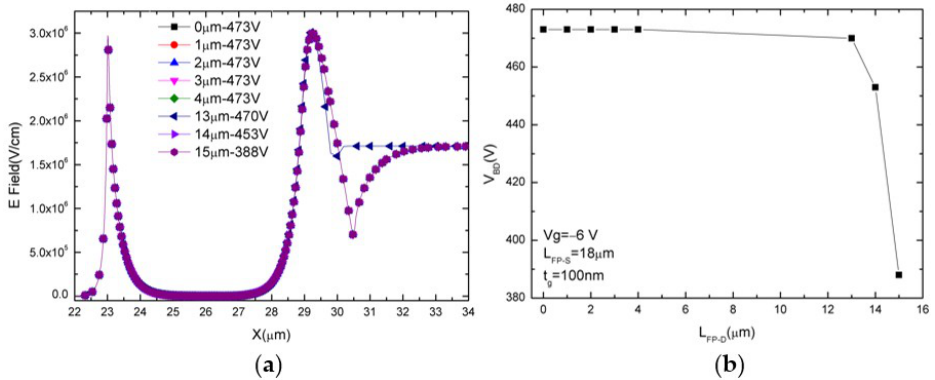
Figure 7. The electric field distributions along the channel for different values of ( a ) L FP-D . Off-state breakdown voltage V BD for different values of ( b ) L FP-D .